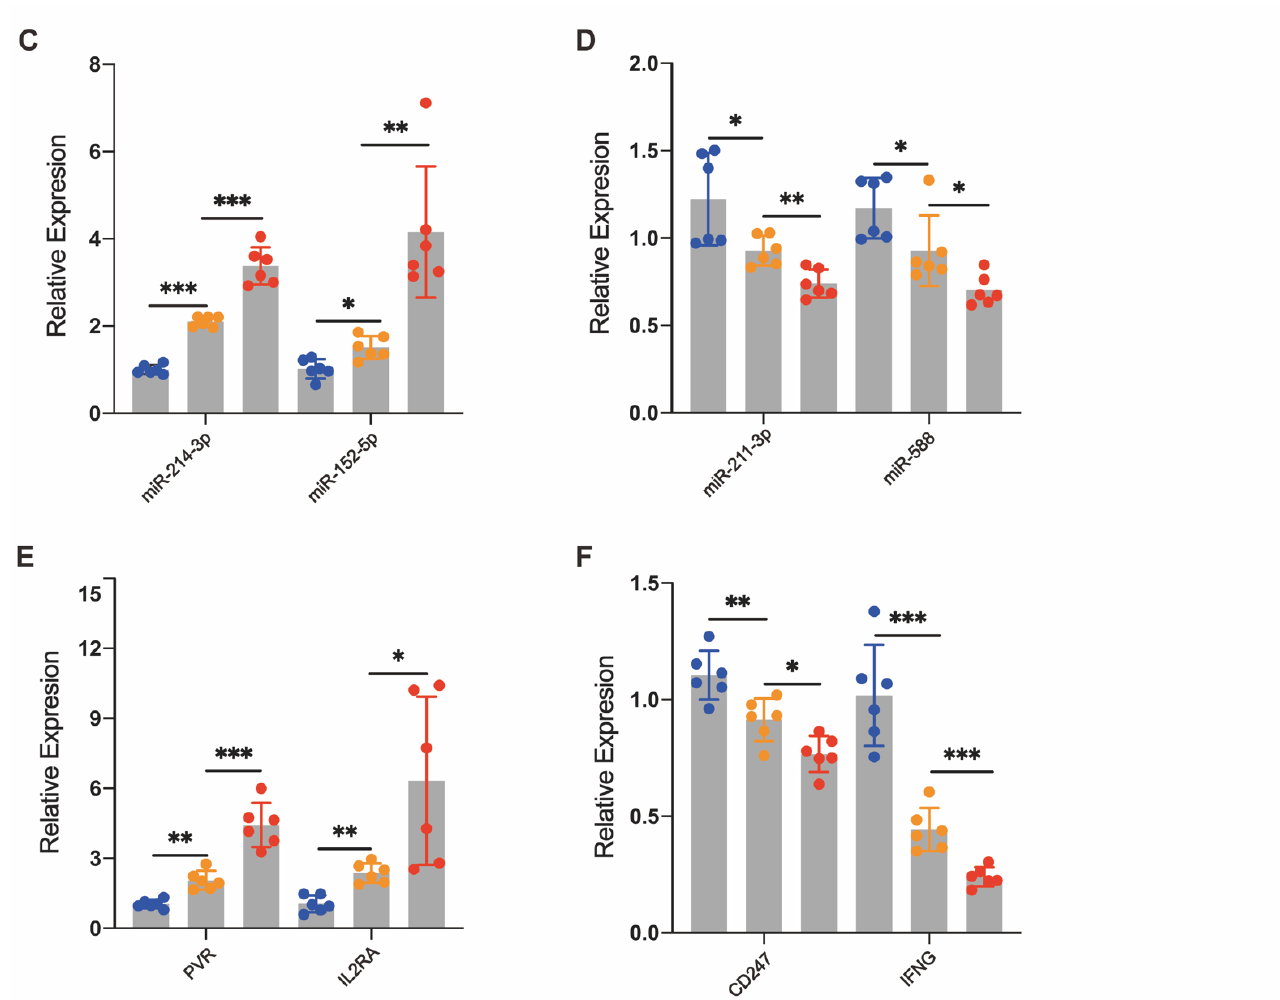
Figure 7. Validation of DE circRNAs in AML patients with pairwise diagnosis (DX) and relapse (RE) and controls (CR or HC) . The RT-qPCR detected the relative expression levels of DE circRNAs ( A , B ) and their associated DE miRNAs ( C , D ) and DE mRNAs ( E , F ), which were selected randomly from the ceRNA regulatory network in an independent cohort ( n = 6 per group). * p < 0.05; ** p < 0.01; *** p < 0.001.